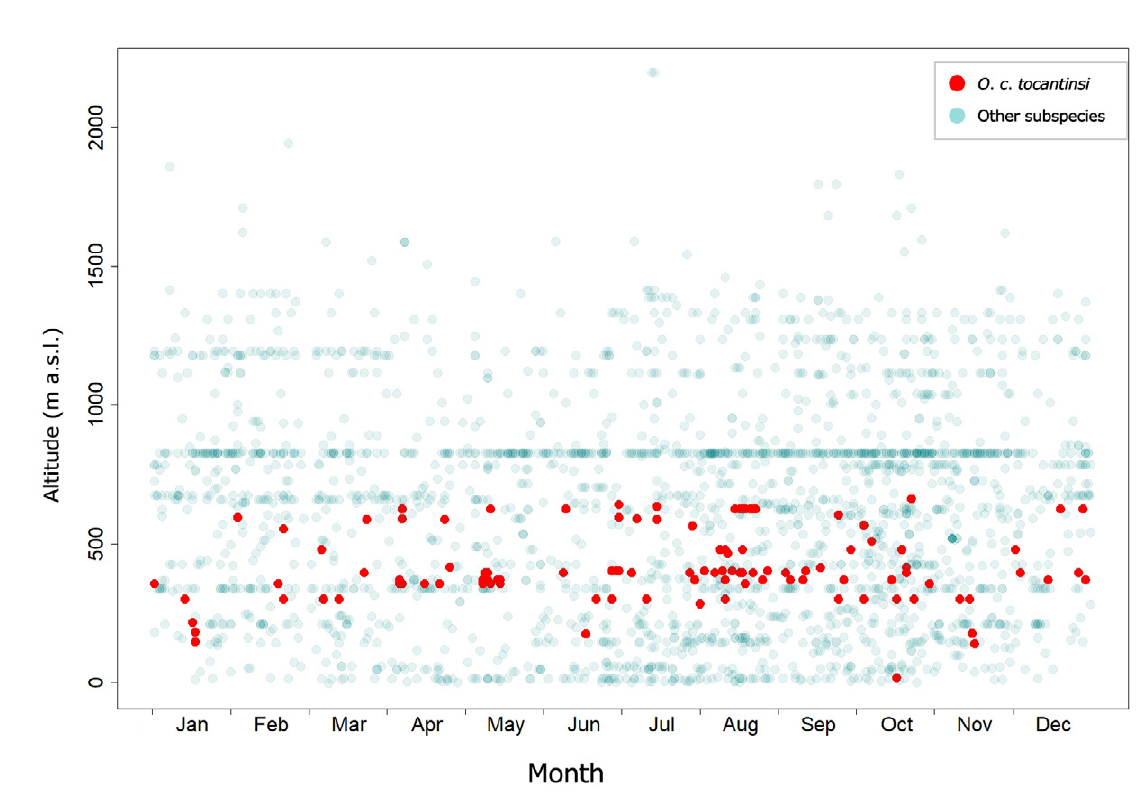
Figure 3. Annual altitudinal variation within the records of Oxyruncus cristatus , with emphasis on O . c . tocantinsi